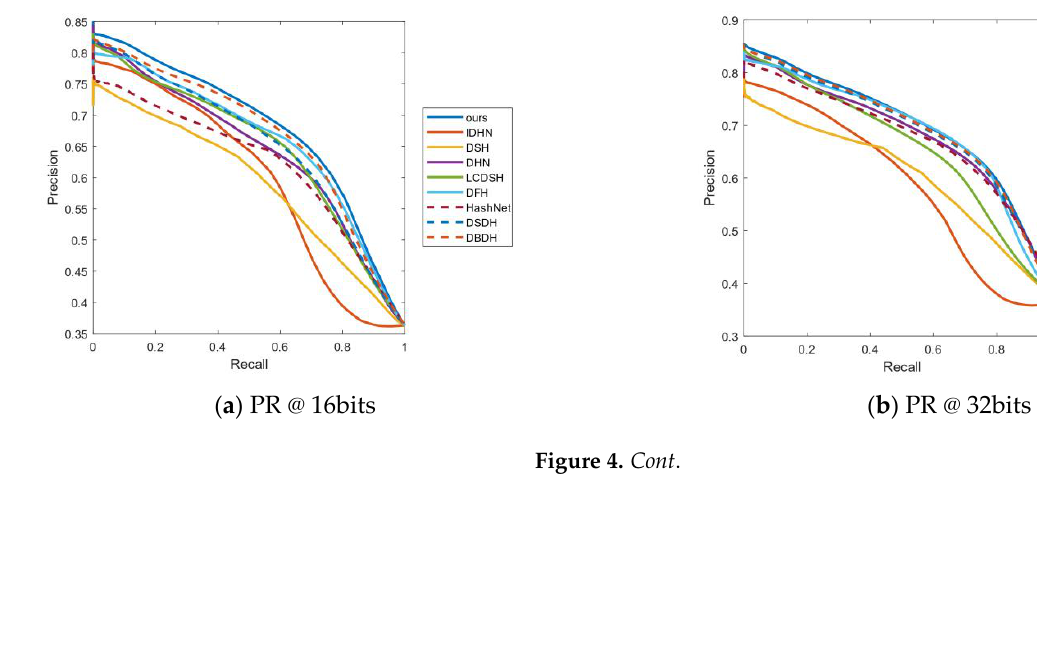
Figure 3. ( a – d ) represent the PR curves on CIFAR-10 of all algorithms when the length of the hash code is 16 bits, 32 bits, 48 bits and 64 bits, respectively.